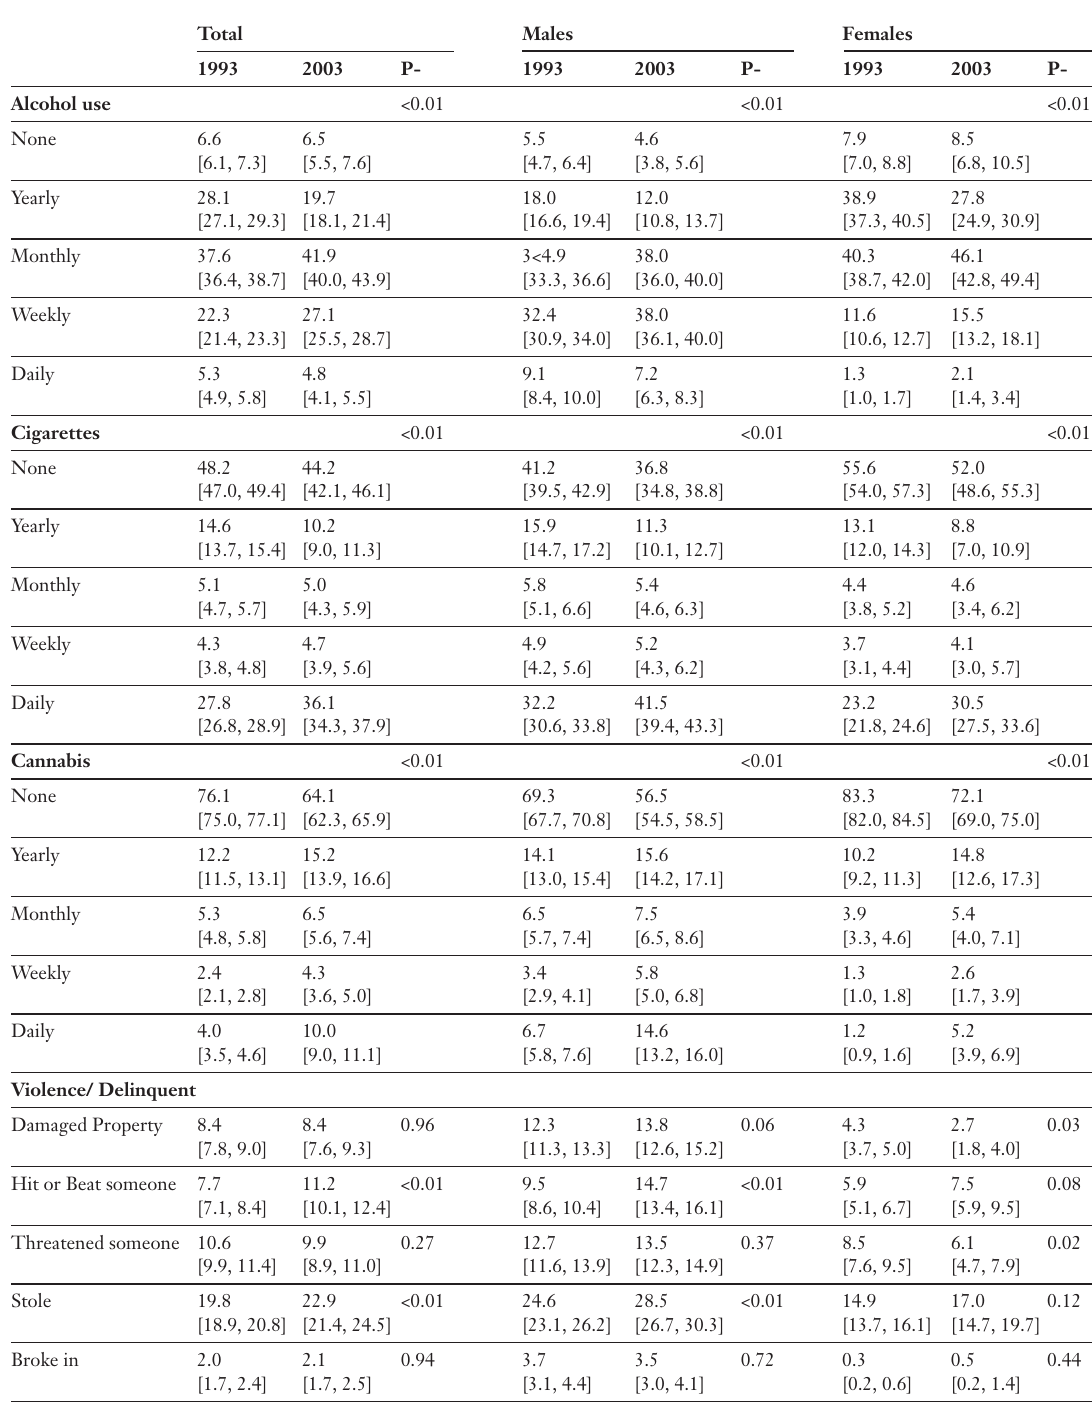
Table 3 Differences in Health Behaviour between 1993 and